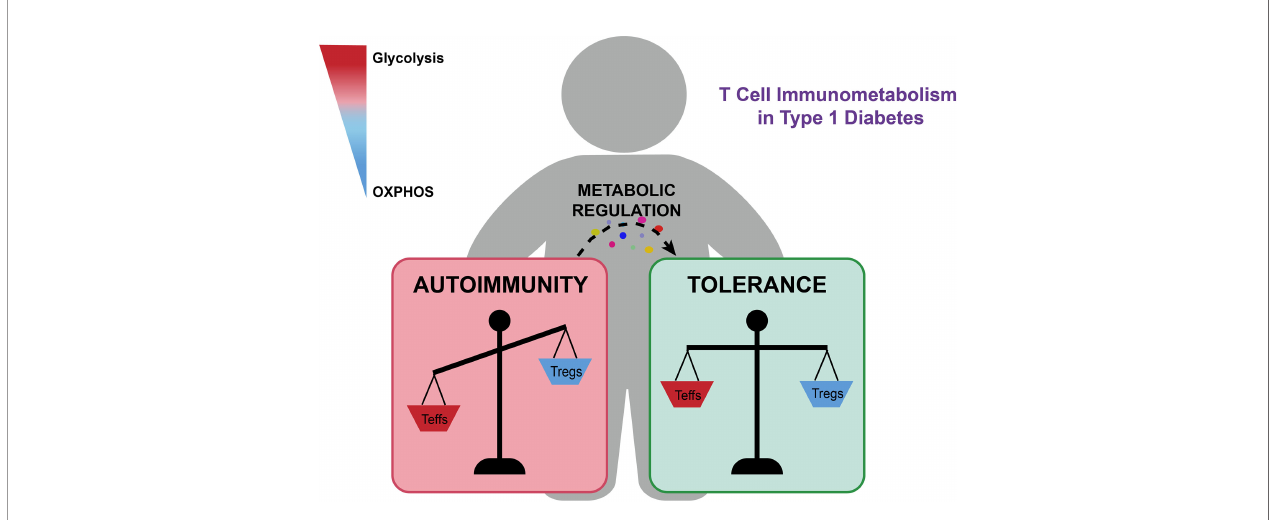
FIGURE 1 | The metabolic imbalance of autoreactive T cells and Tregs contributes to T1D development and progression. Glycolysis supports pro-in fl ammatory responses, while OXPHOS promotes anti-in fl ammatory responses and immune tolerance. Immunometabolism regulators of key metabolic pathways, such as metformin and PFK15, could suppress effector T cell responses and facilitate Treg expansion and function, which could provide a promising metabolic intervention strategy for limiting the progression of b -cell destruction and reversing pathologies of